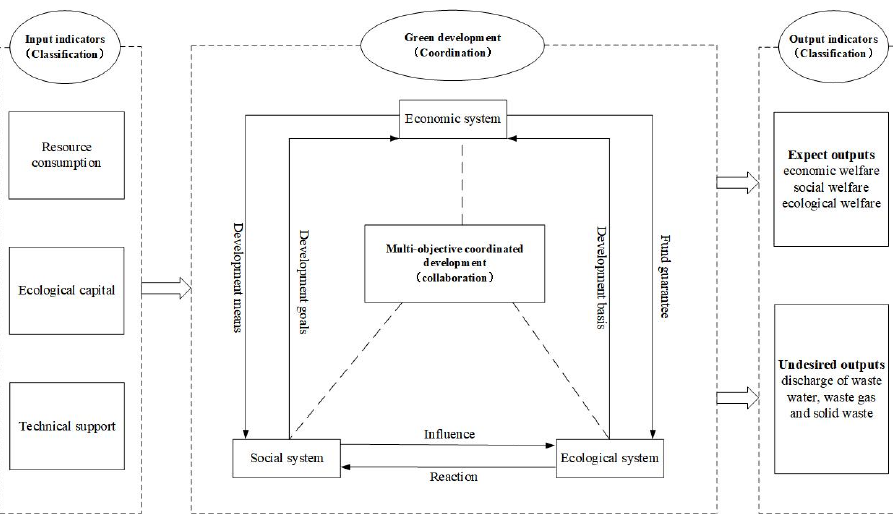
Figure 1. “Classification–Coordination–Collaboration” Analysis Framework of EWP.